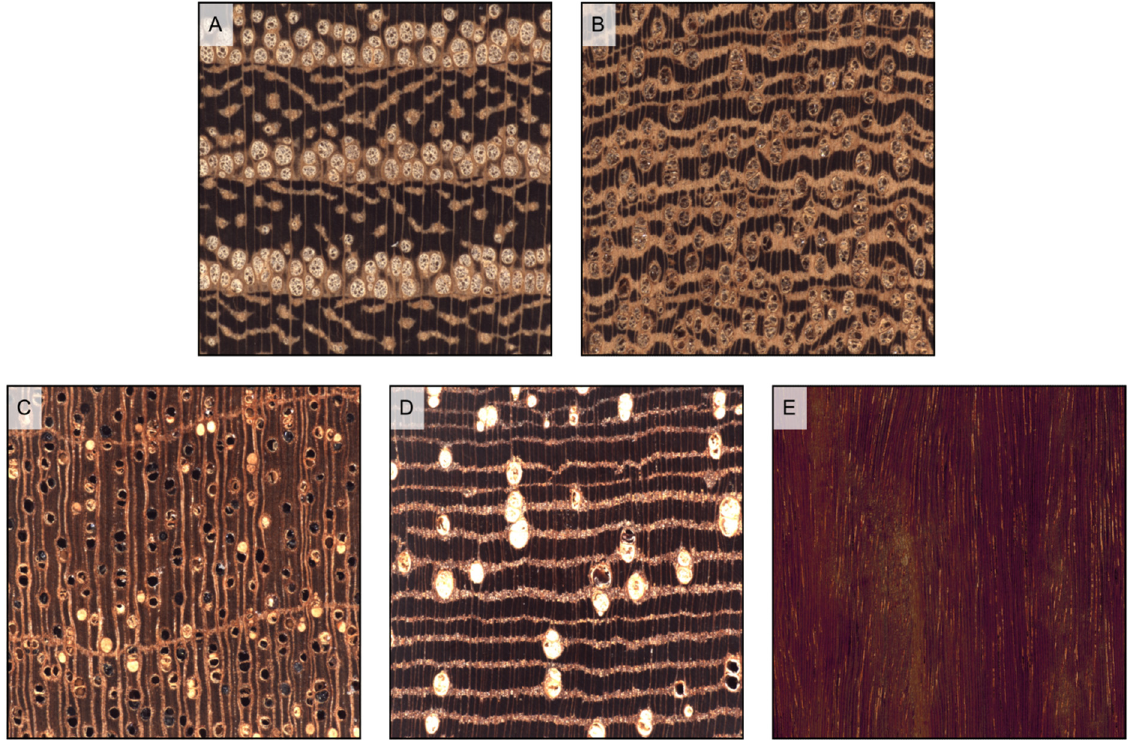
Figure 16. Vessel deposits (all transverse sections except E , longitudinal section). Tyloses in the vessels of Robinia pseudoacacia ( A ) and Morus mesozygia ( B ); gums in the vessels of Swietenia humilis ( C ) and Lophira alata ( D , E ). Table 16. Examples of species for different types of vessel deposits. Vessel Deposits